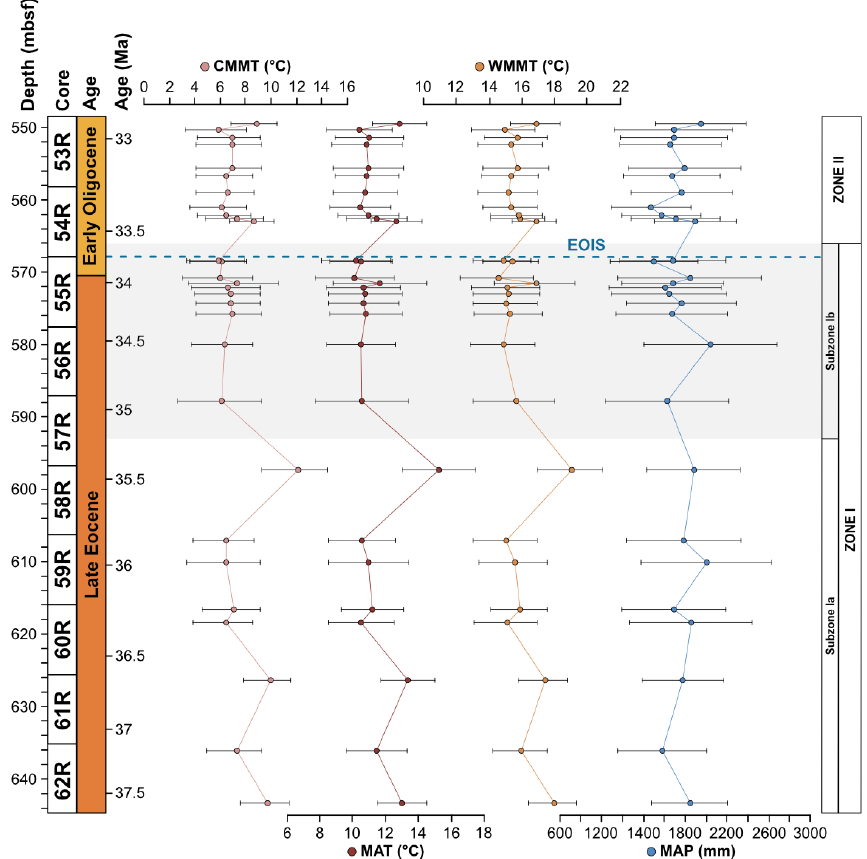
Figure 4. Sporomorph-based quantitative climate estimates using probability density functions (PDFs). From left to right: coldest-month mean temperature (CMMT), mean annual temperature (MAT), warmest month mean temperature (WMMT), and mean annual precipitation